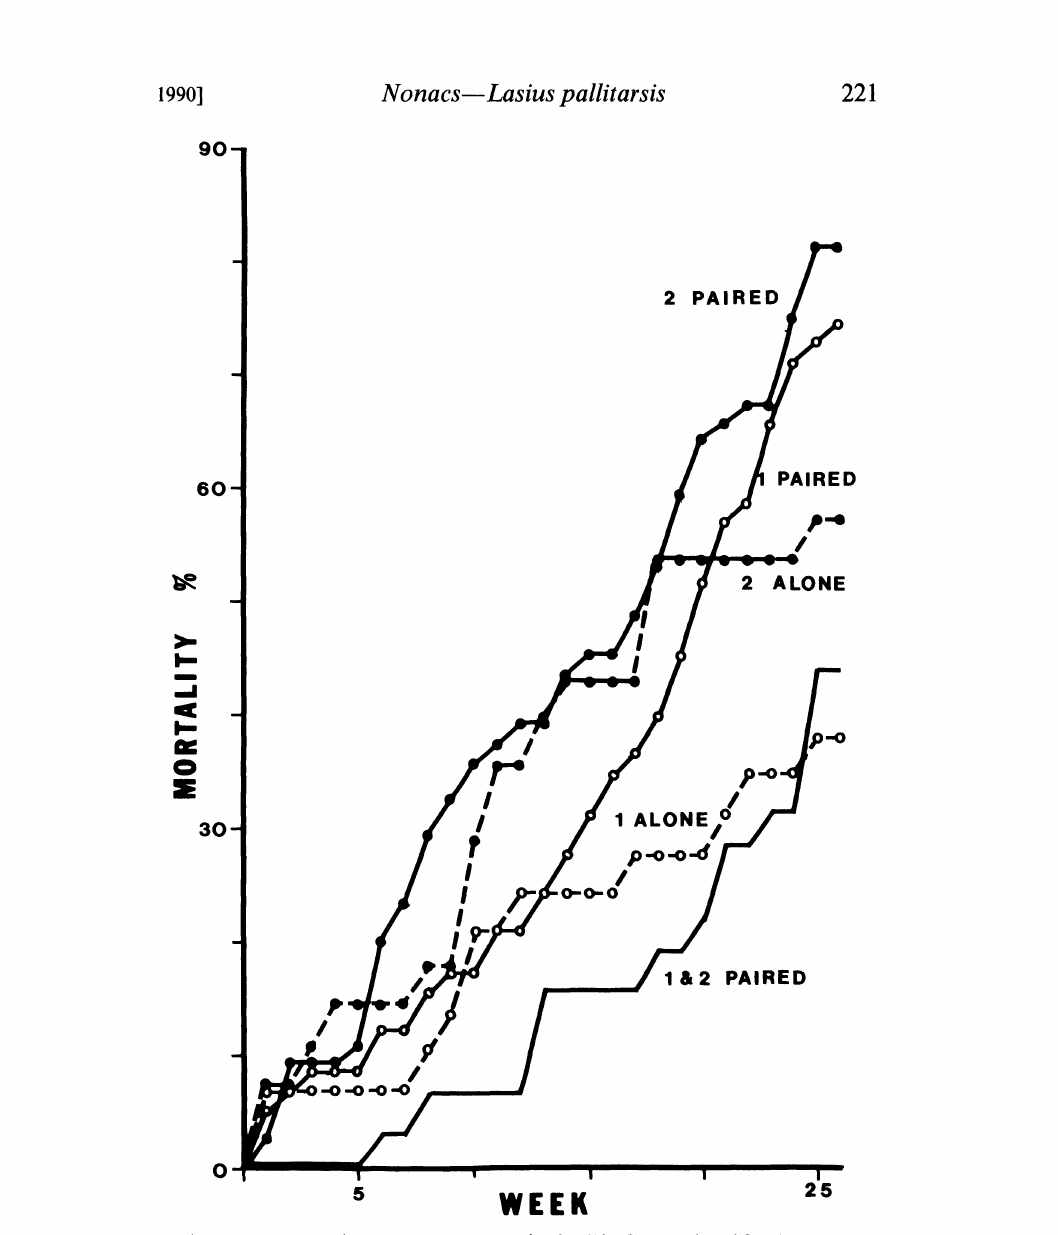
Figure I. Cumulative percentage mortality for Kin Groups and 2, when they are alone, with kin or with non-kin. Solid and dashed lines represent pairs or single queens, respectively. Treatments with only Group are shown with and treatments with only Group 2, by